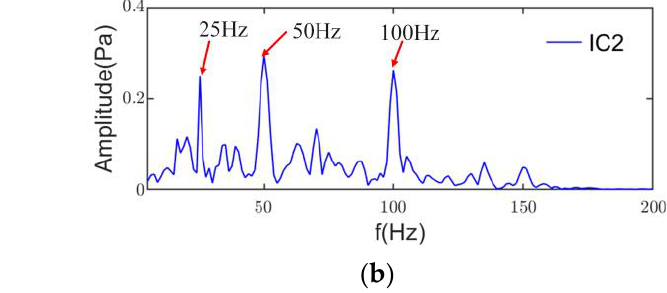
or f r = n 2 z 2 f 1 (1 − s )/ p ± 2 f 1